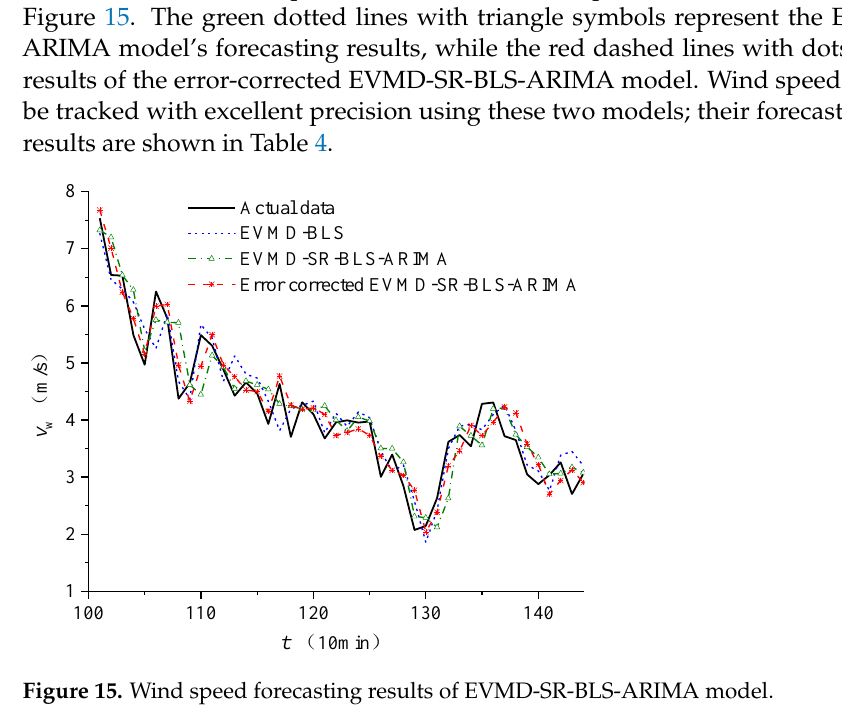
1 ~ u 5 and the low-entropy-value sequences as